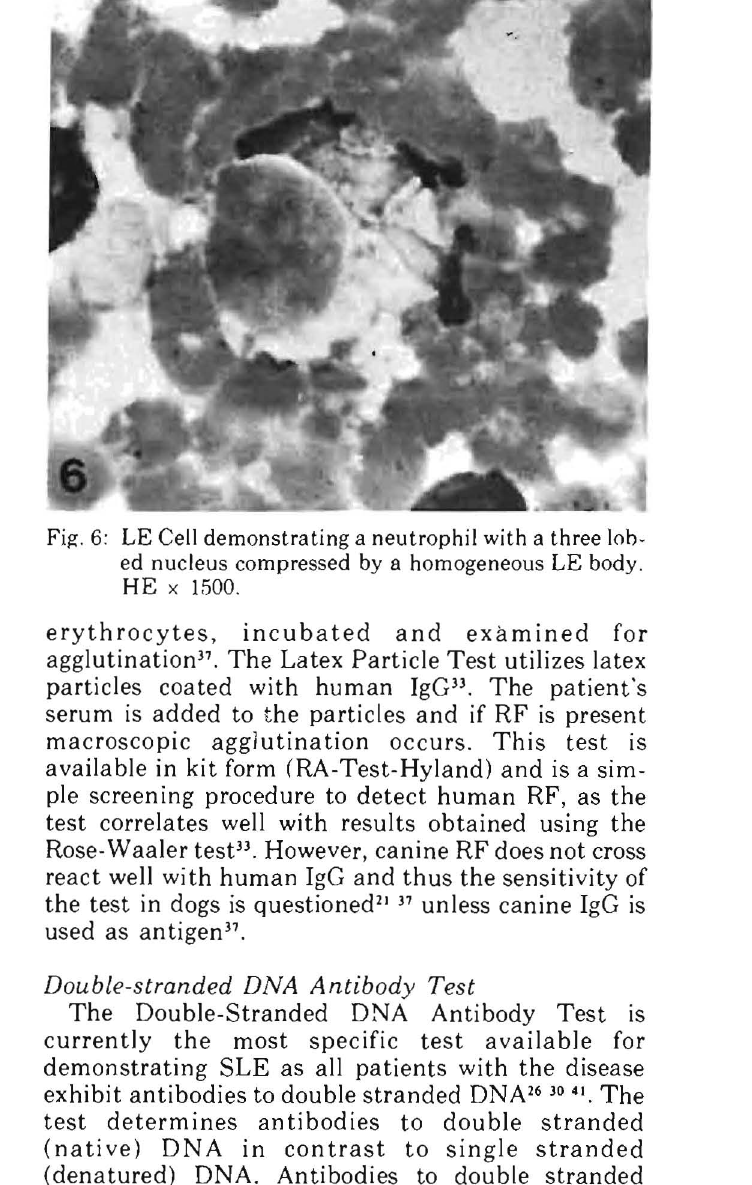
Fig. 6: LE Cell demonstrating a neutrophil with a three lob ed nucleus compressed by a homogeneous LE body. HE x